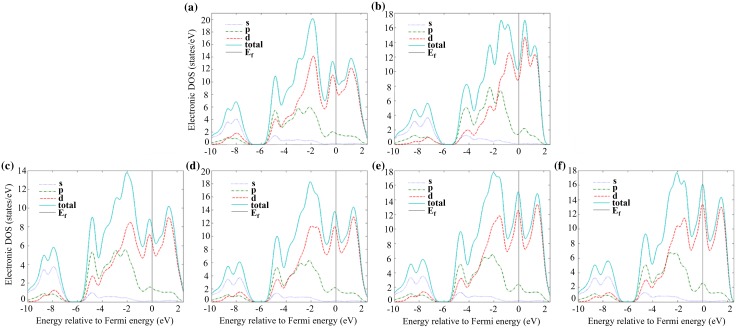
Partial and total density of states of (a) γNb5Si3, (b) Ti5Si3, (c) γNb9TiSi6, (d) γNb8Ti2Si6, (e) γNb7Ti3Si6, (f) γNb6Ti4Si6.